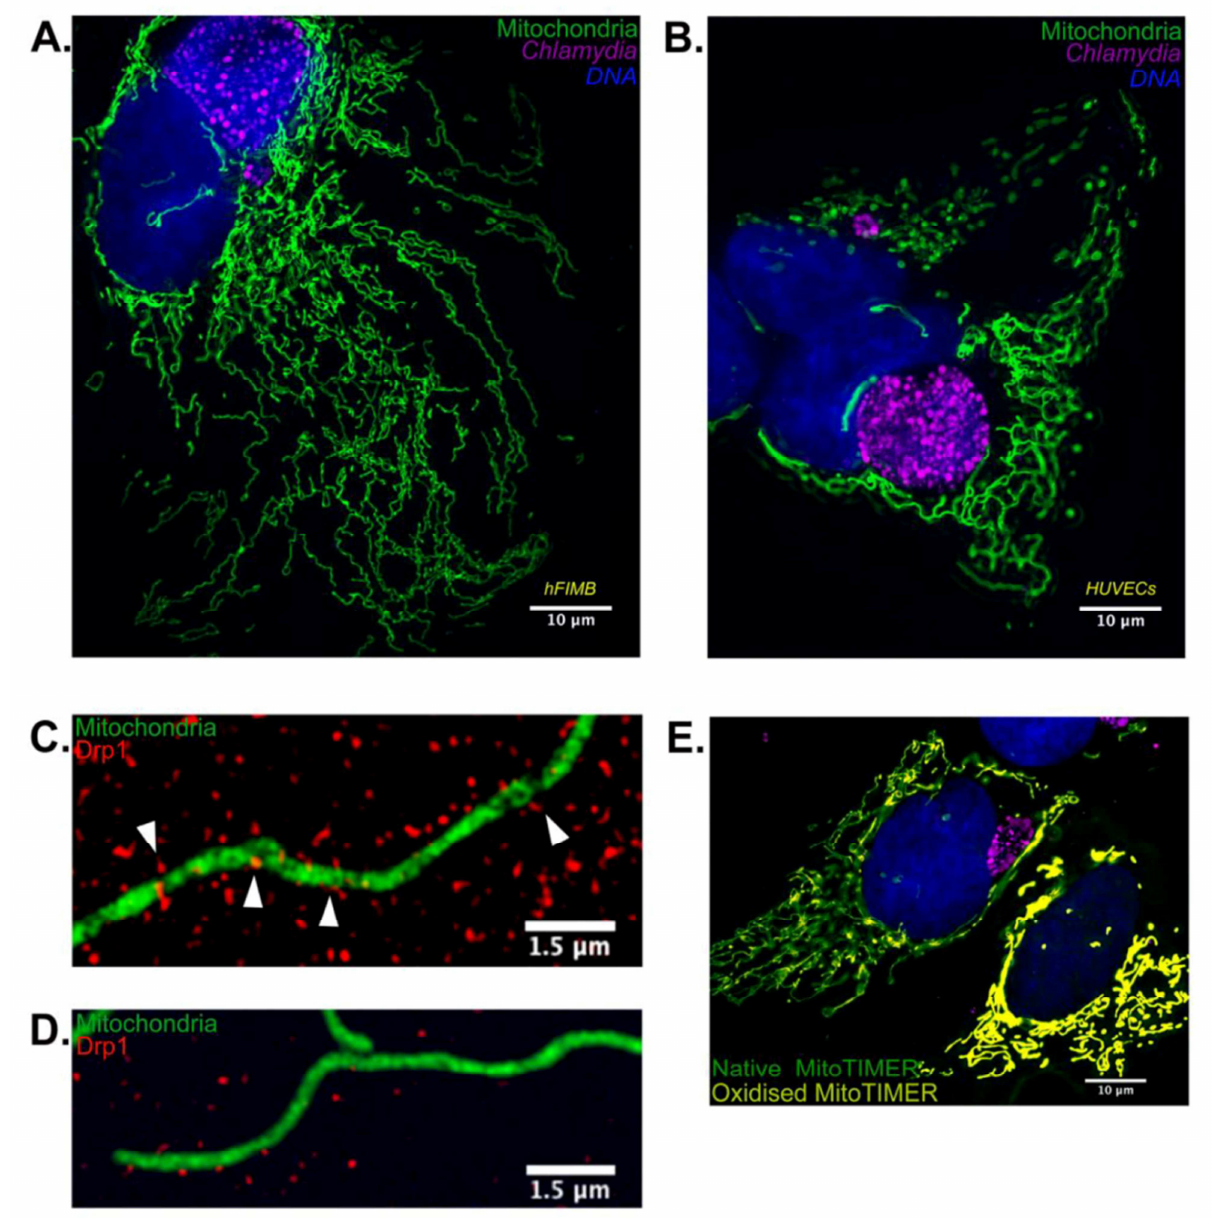
FIGURE 1: Chlamydia infection alters mitochondrial morphology in primary cells by inhibition of Drp1 expression. (A) 36 hours of Chla- mydia infection in hFIMB cells lead to an abnormal increase in mitochondrial fragment length while preventing H 2 O 2 mediated fragmenta- tion. The sample was treated with 1μM H 2 O 2 for 1 hour. (B) In this panel both the HUVECs have been treated with CoCl 2 for 6 hours, howev- er, only the cell harboring a very early stage Chlamydia inclusion (8 hours) undergoes severe mitochondrial fragmentation. Advanced stages of Chlamydia infection (36 hours; right most cell) grants the host cell mitochondria protection against extrinsic pro-fragmentation stress mediated by CoCl 2 . Fragments of mitochondria from (C) non-infected and (D) Chlamydia -infected HUVECs decorated with Drp1 aggregates. The white arrows in (C) indicate successful Drp1 aggregate association with the mitochondria and initiation of fission. (E) HUVECs transfect- ed with MitoTIMER and infected with Chlamydia for 20 hours. The non-infected cell (right most) exhibits a drastic increase in the red form (oxidized form) of the MitoTIMER protein along with a decrease in mitochondrial fragment